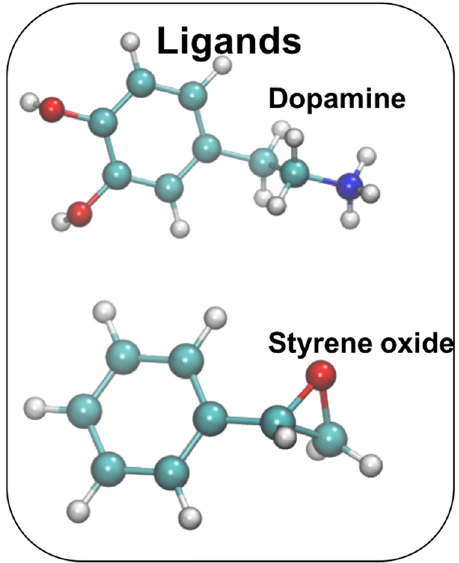
Figure 2: Dopamine ( top ) and styrene oxide ( bottom ) structures. Hydrogen atoms are white, carbon atoms are green, oxygen atoms are red, and nitrogen atoms are